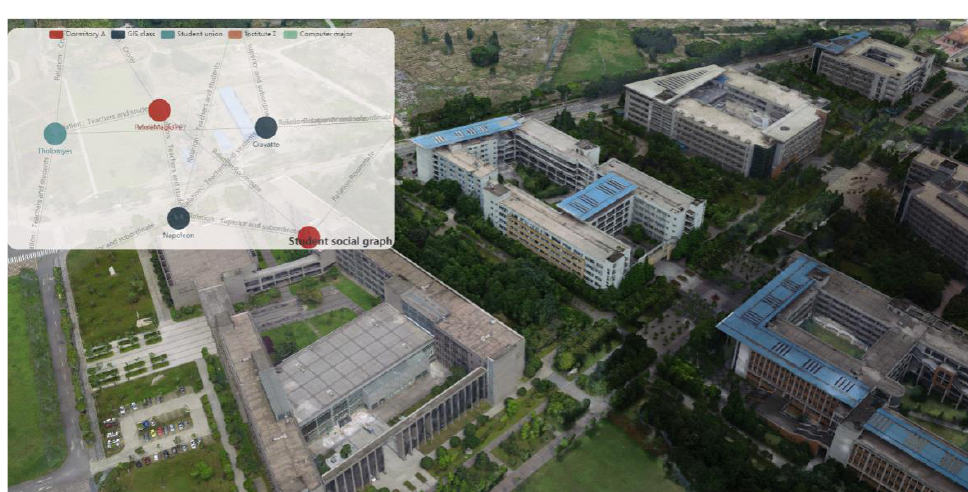
( c ) Analytical visualization task: Students' social relations on the campus. Figure 7.